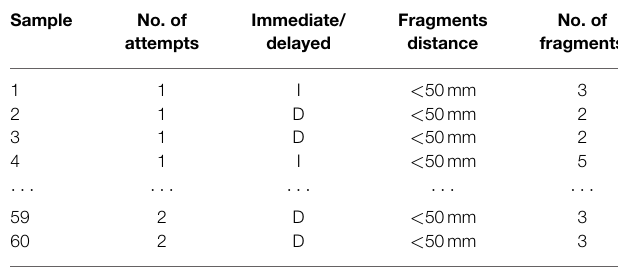
manner, how many fragments were produced, whether there are any fragments ejected outside of a 50 mm radius from the center of the sample.